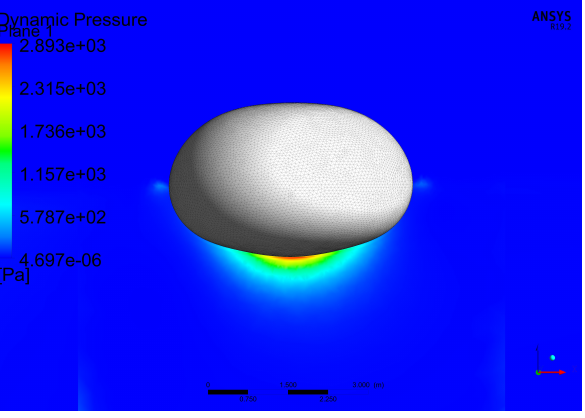
Figure 15. Dynamic pressure field measured around the device at t = 0.5